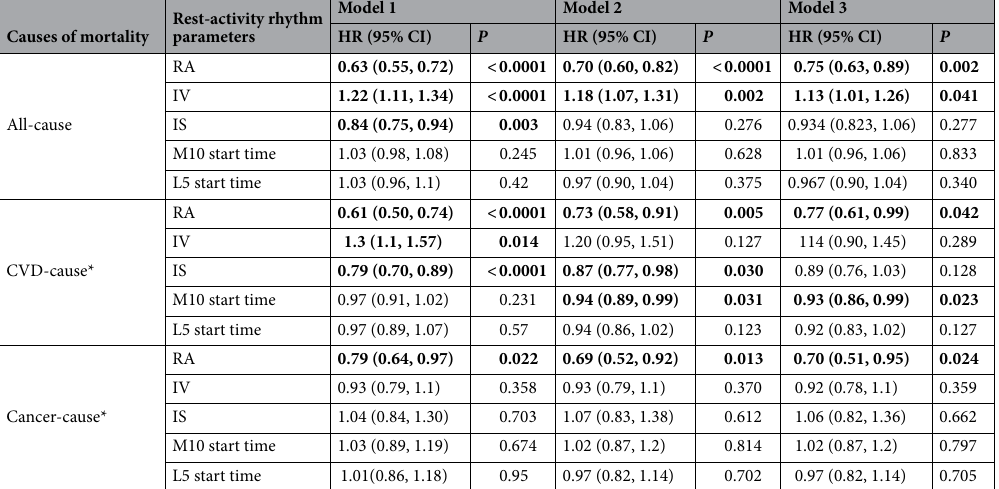
Table 2. Associations of rest-activity parameters with all-cause and cause-specific mortality. Model 1: Adjusted for age at baseline, race, sex. Model 2: Adjusted for age at baseline, race, sex, ratio of family income to poverty, education, physical activity, smoking, alcohol drinking, sleep efficiency, sleep duration. Model 3: Adjusted for age at baseline, race, sex, ratio of family income to poverty, education, physical activity, smoking, alcohol drinking, sleep efficiency, sleep duration, general health, BMI, hypertension, CVD, cancer, stroke, diabetes. RA Relative amplitude; IS Interdaily stability; IV Intradaily variability; M10 The most active continuous 10-h period; L5 The least active continuous 5-h period. *Model 3: Adjusted for age at baseline, race, sex, ratio of family income to poverty, education, physical activity, smoking, alcohol drinking, sleep efficiency, sleep duration, general health, BMI, hypertension. Significant values are in [bold].